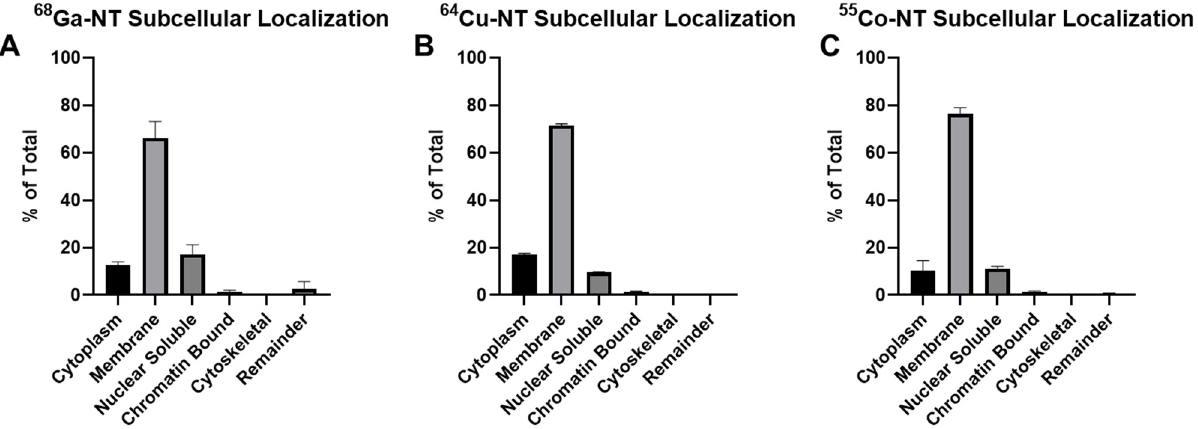
Figure 2. Subcellular localization of NOTA-NT-20.3 labeled with gallium-68, copper-64, and cobalt-55 shows primarily membrane localization after 1 h of incubation. Cell localization was investigated using [ 68 Ga] Ga-NOTA-NT-20.3 ( A ), [ 64 Cu] Cu-NOTA-NT-20.3 ( B ), and [ 55 Co] Co-NOTA-NT-20.3 ( C ). PET/CT imaging of the radiolabeled NOTA-NT-20.3 peptide shows significant tumor